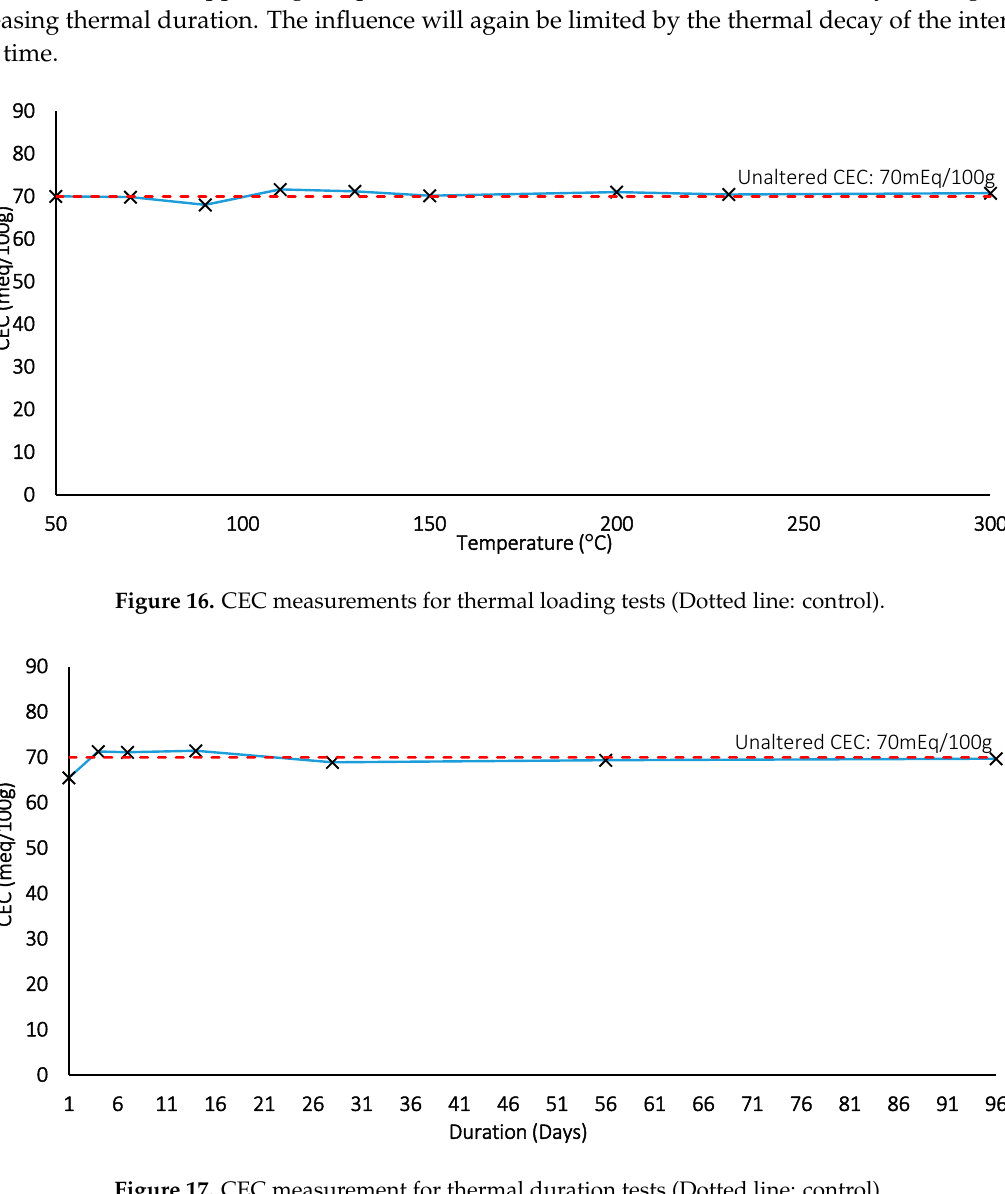
Figure 17. CEC measurement for thermal duration tests (Dotted line: control).